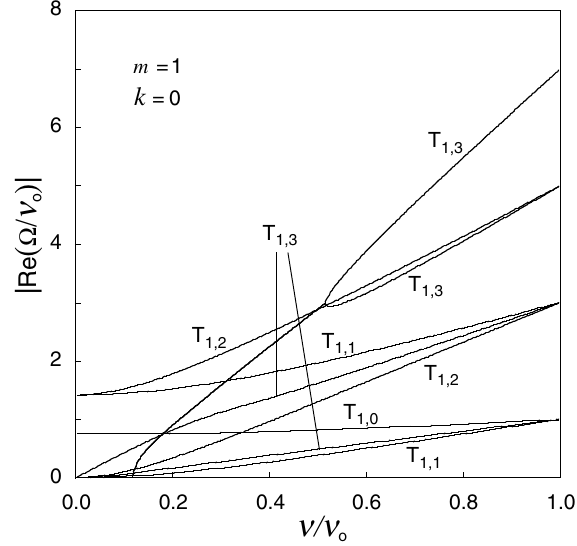
FIG. 1. Absolute value of the real part of (cid:13) =(cid:10) nine dipole modes as a function of (cid:10)=(cid:10) and zero wall impedance ( Z (cid:3) 0